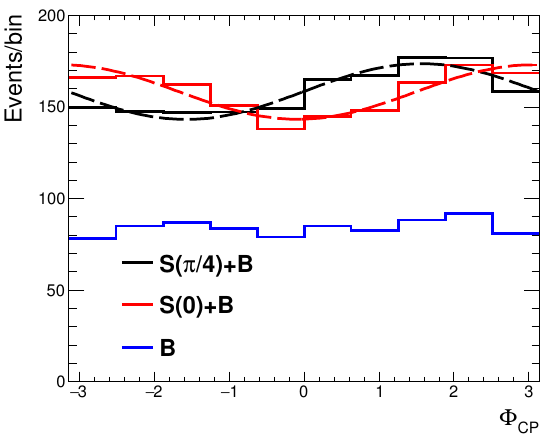
Figure 4 . (cid:8) CP distribution after all selection cuts as in table 1, for the Z + (cid:21) 2 (cid:0) jets background (blue), and the combined distribution of the h + (cid:21) 2 (cid:0) jets signal and the background events, for the CP-mixing angle (cid:1) = 0 (red) and (cid:1) = (cid:25)= 4 (black). The event numbers correspond to an integrated luminosity of 3000 fb (cid:0) 1 at the 14 TeV